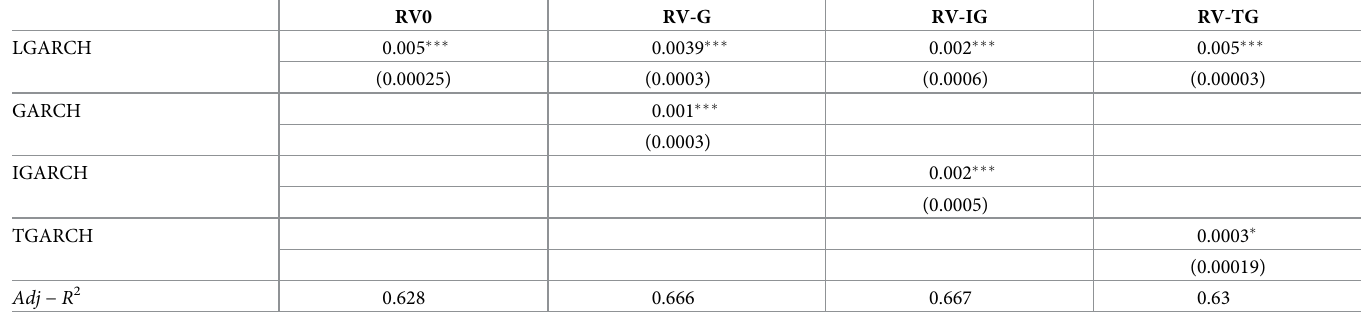
Table 10. Regression results for realized variance (out-of-sample). This table reports the Mincer-Zarnowitz regression result for the model performance comparison regarding the out-of-sample realized variance. RV0 represents the single variable regression for our model only, RV-G represents the model 1 is our model and model 2 is GARCH model defined in Eq (13); RV-IG represents the model 1 is our model and model 2 is IGARCH model defined in Eq (13); RV-TG represents the model 1 is our model and model 2 is TGARCH model defined in Eq (13). � , �� , ��� indicate statistical significance at 10%, 5% and 1% levels, respectively.